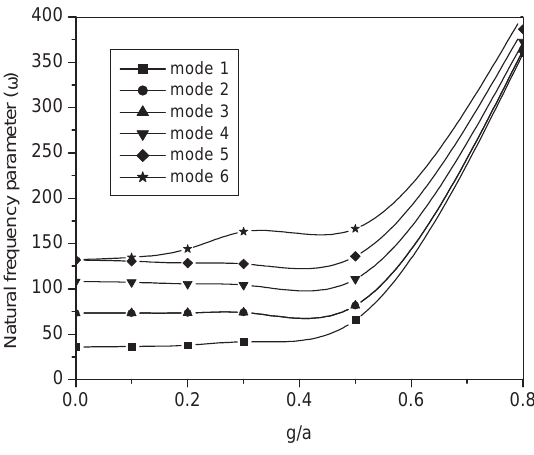
Fig. 7. Fundamental frequency parameter for a square plate with a square cutout subjected to bi-axial compressive forces. ical values of Olson and Hazell [11]. Computation